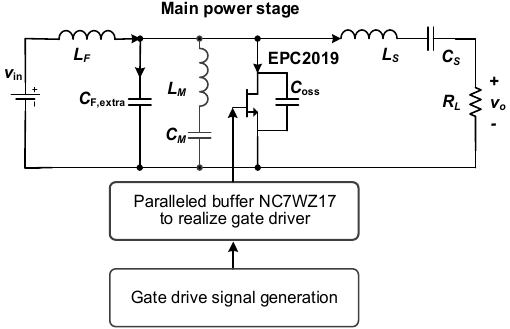
Figure 11. Block diagram of the prototype.